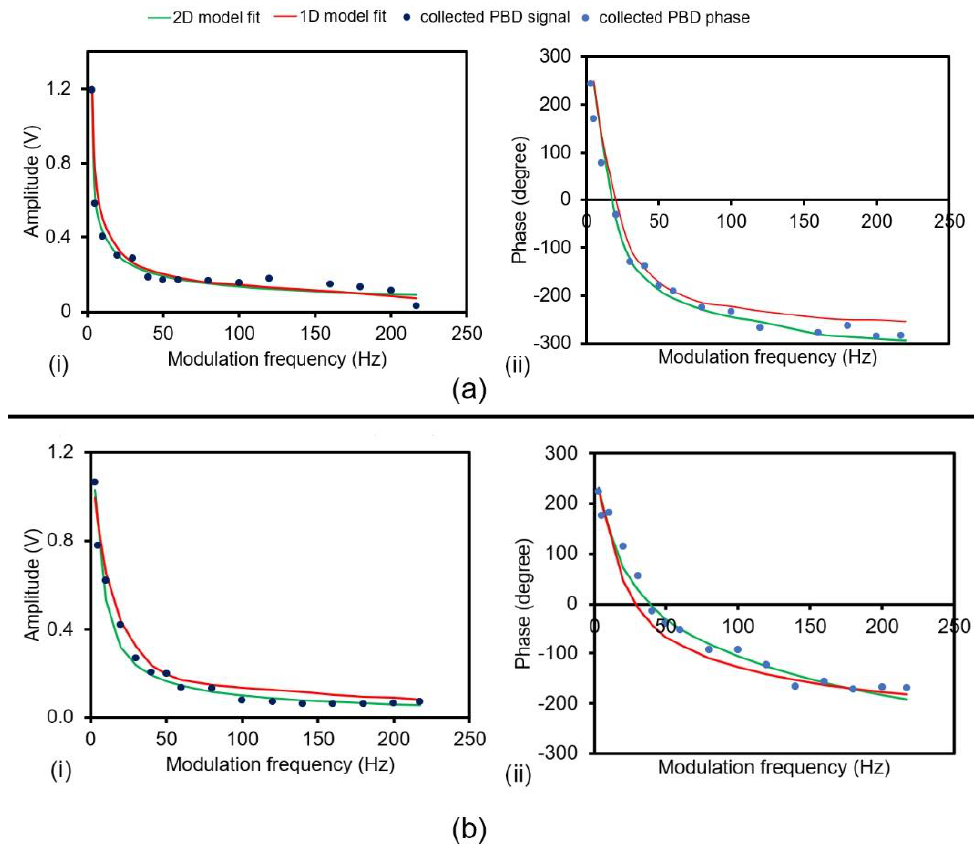
Figure 5. Variations in the ( i ) amplitude and ( ii ) phase of the PBD signal with respect to the modulation frequency of PuB, for the case of maximum PuB defocussed, ( a ) at f = 5.3 cm and ( b ) at f = 4.7 cm, along with the fitting curves using 1D and 2D models.